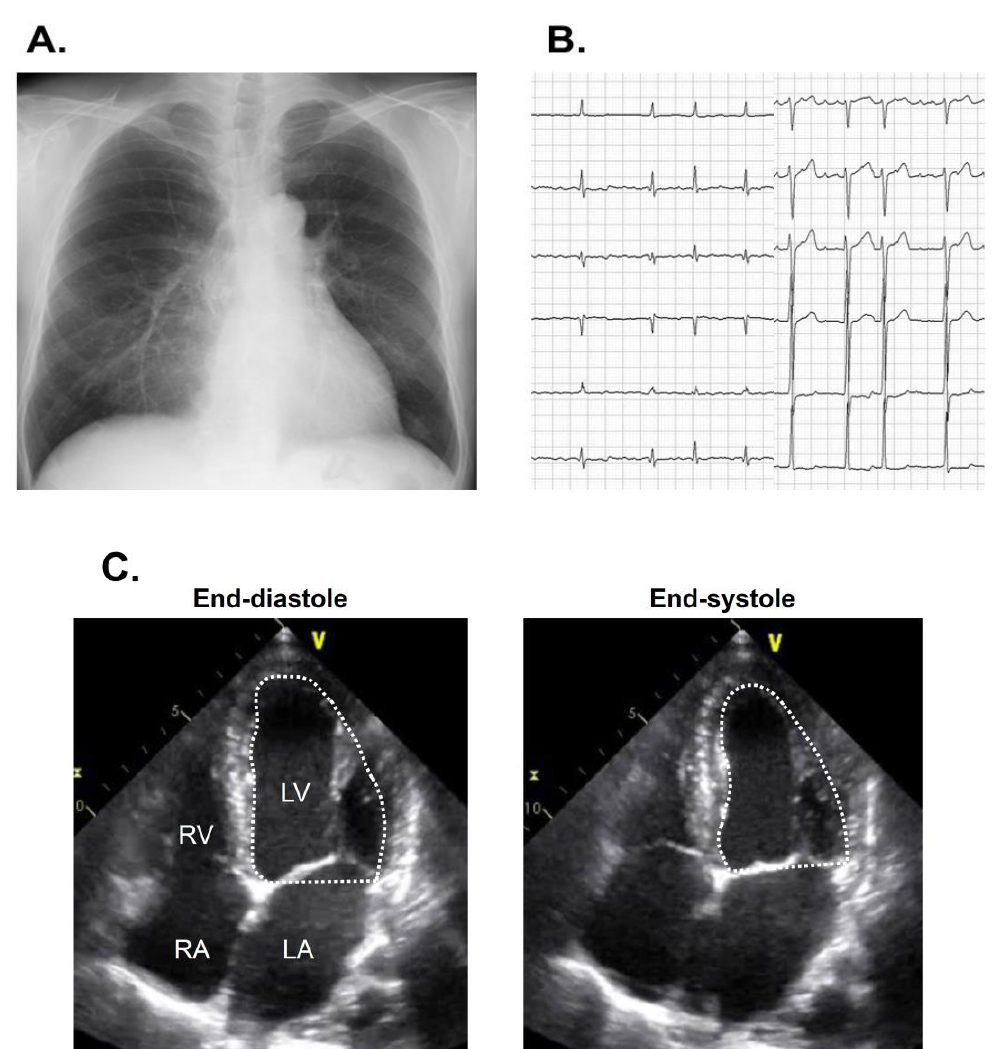
Figure 1. Chest X-ray showing 47% of cardiothoracic ratio ( A ), electrocardiogram showing atrial fibrillation ( B ), and transthoracic echocardiography showing reduced left ventricular ejection fraction on admission ( C ) on admission. LA, left atrium: LV, left ventricle; Ao, ascending aorta; RA, right atrium; RV, right